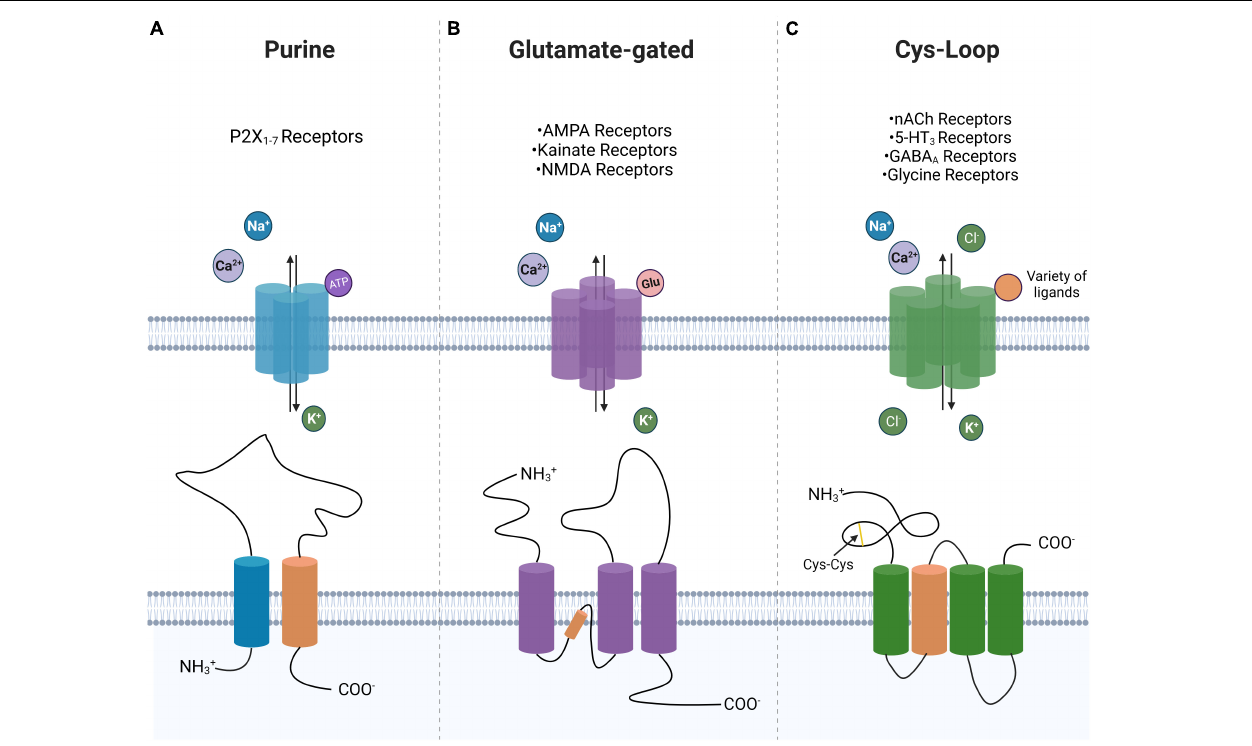
FIGURE 1 | Ligand-gated ion channel superfamily morphology. Shown is a near top-down view displaying preferred ligand and ion selectivity for P2-type ionotropic purinoreceptors (A) , glutamate-gated ionotropic receptors (B) , and Cys-loop receptors (C) . A schematic of the transmembrane domain of each of the three superfamilies is shown with their ligand-interacting domain displayed in orange. Highlighted is the cys-cys loop in the Cys-loop superfamily. Created with